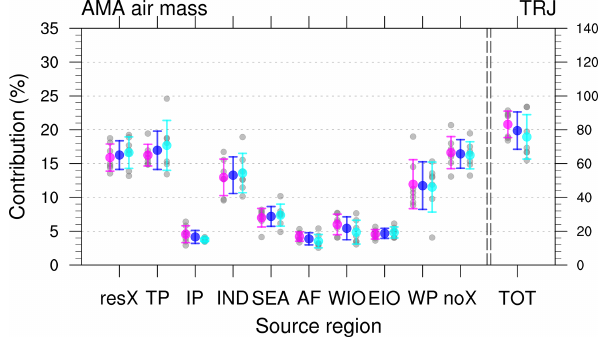
Figure 9. Contributions from different source regions to AMA air masses at 150hPa during JJA. The categories resX and noX corre- spond to the trajectories that reached the PBL outside the defined source regions (see Fig. 1) or did not reach the PBL within 90d prior to their start, respectively. TOT corresponds to the total num- bers of trajectories released within the AMA and is given in units of 10 3 trajectories. The mean values are given by blue dots with blue whiskers for the interannual standard deviation. The mean values and interannual standard deviation split according to the east (west) location of the AMA are given as cyan (magenta) dots and whiskers, and the individual years are shown as grey